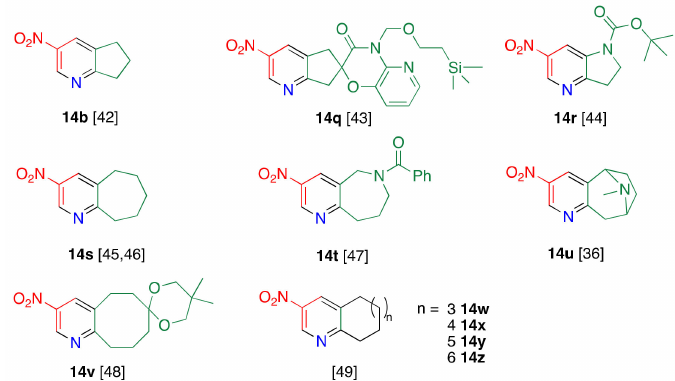
Figure 3. Nitropyridines condensed with a five-membered ring and with a larger